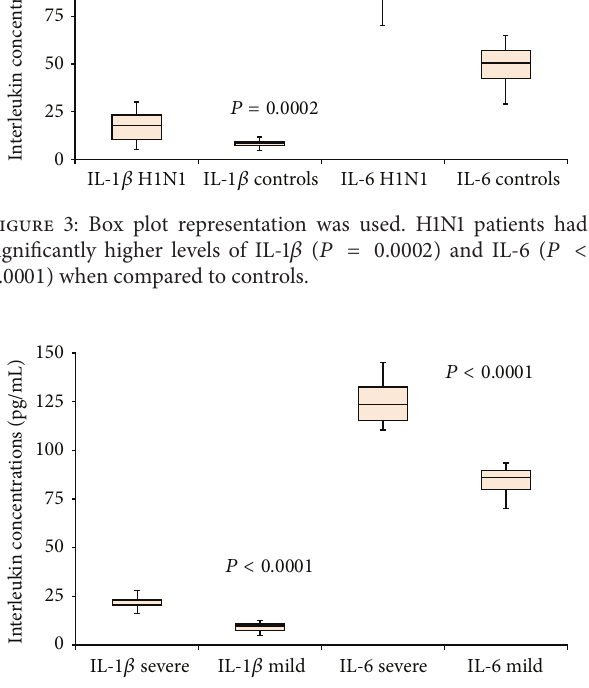
Figure 4: Box plot representation was used. H1N1 patients with severe disease had significantly higher levels of IL-1 𝛽 ( 𝑃 < 0.0001 ) and IL-6 ( 𝑃 < 0.0001 ) when compared to patients with mild symptoms.